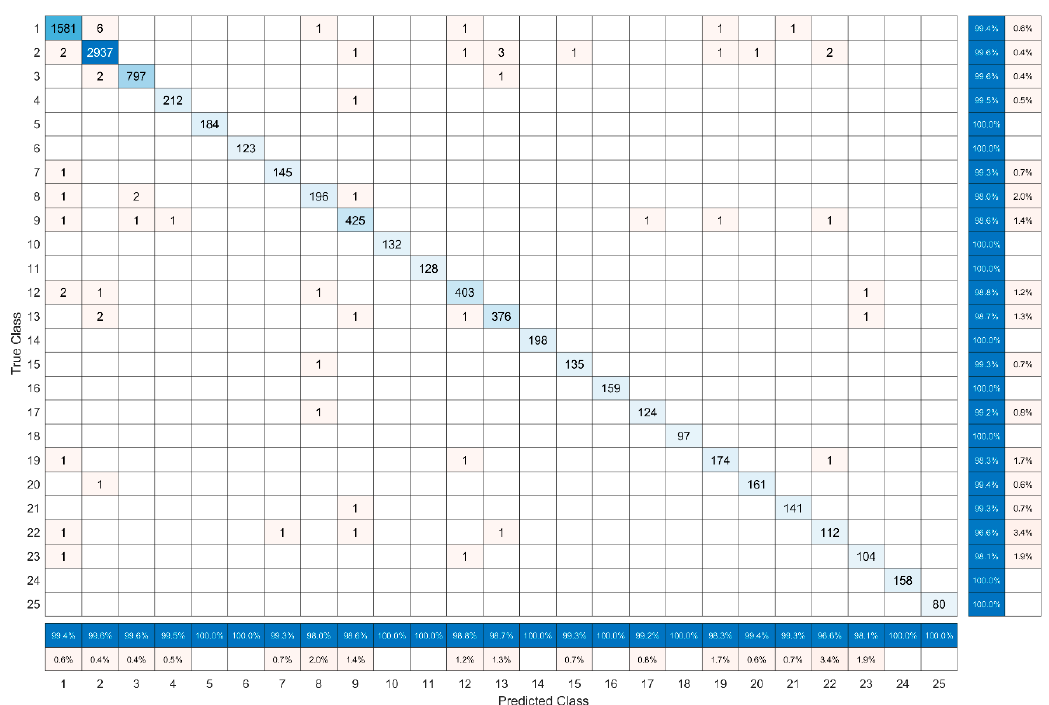
Figure 15. Confusion matrix of the best classifier (cubic SVM with a fusion of SFTA and neural network features).